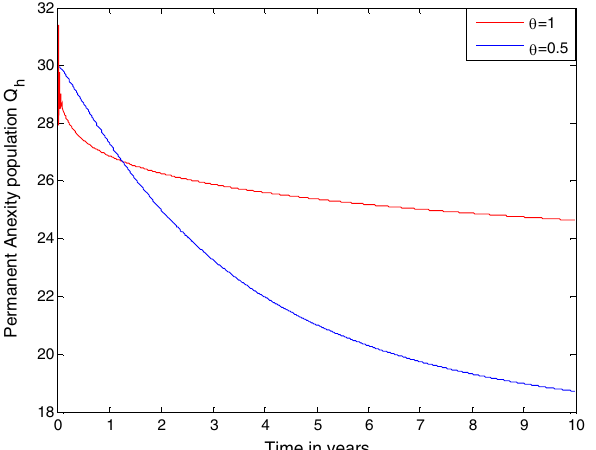
Figure 9. Order of derivative( memory) effects on permanent anxiety infectious population Q h .